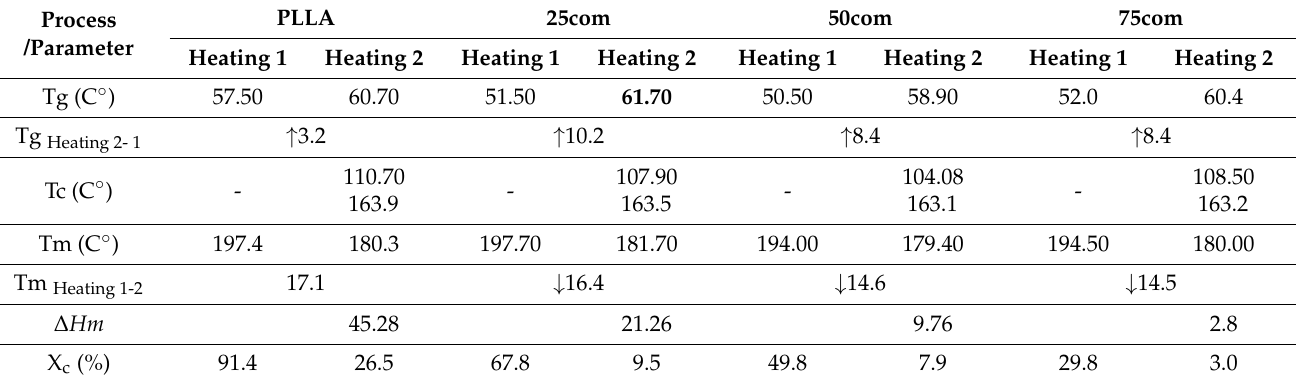
Table 4. Thermal properties of composites in line with the increase in HAP NPs content and for